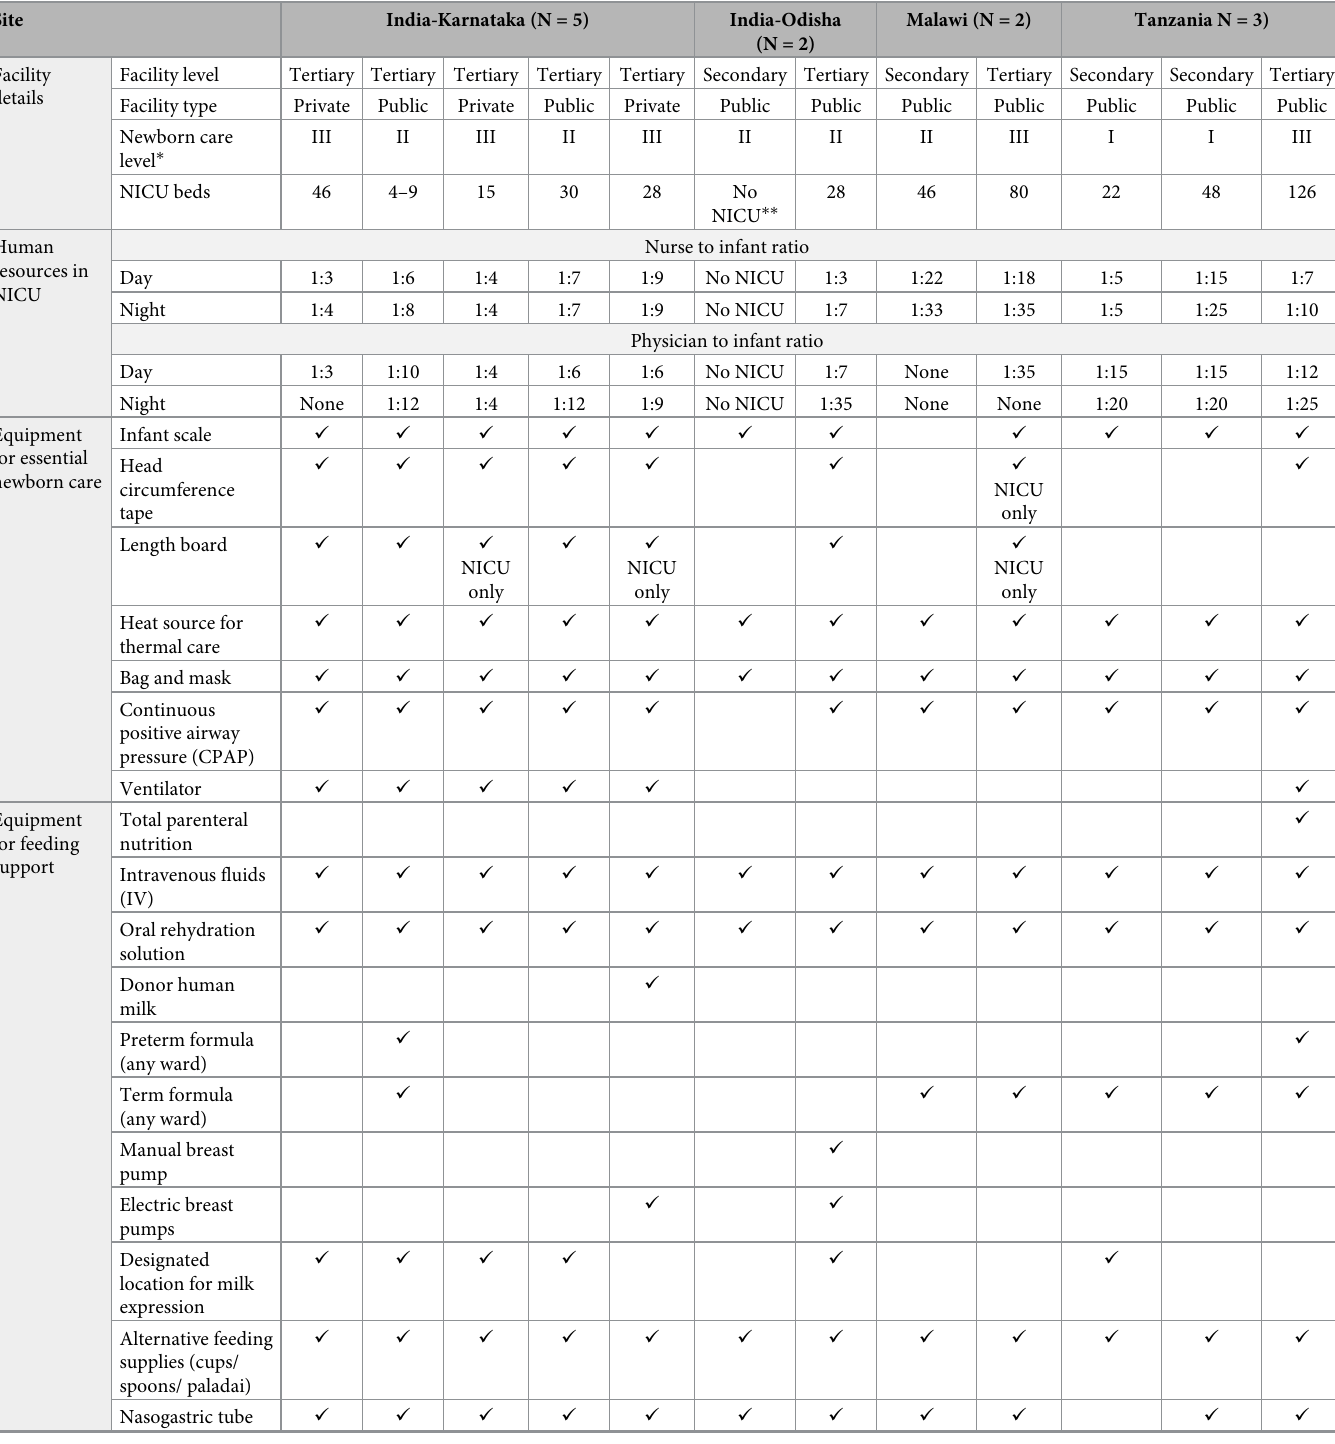
Table 2. Facility-level resources for care of moderately low birthweight infants in 12 facilities in India, Malawi, and Tanzania.